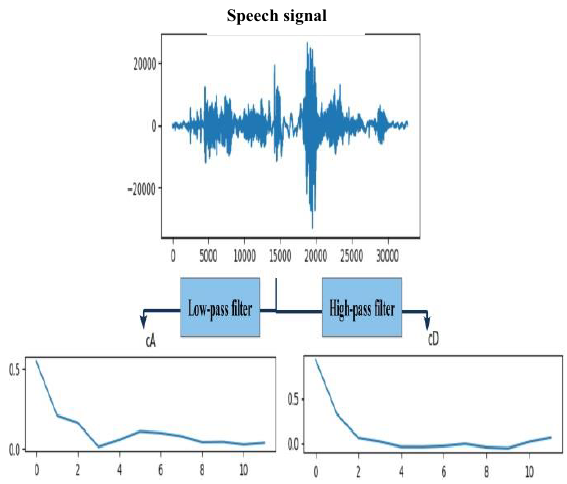
Fig. 2. The decomposition of the signal of an esophageal file sound in approximation A j and details D j by the